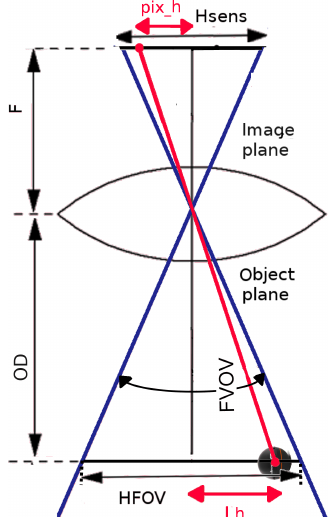
Figure 4. Relationship between FOV (field of view in degrees), HFOV (height of the field of view, in metric unit), OD (object dis- tance), F (focal length), pix h (distance in pixels between center of the image and the object in the image, along the vertical axis of the image captured by the camera), Hsens (sensor height), and Lh (distance in metric units between the object and center of the sen- sor along the vertical axis of the image). The drawing is valid under the assumption that the image distance (distance from the rear nodal point of the lens to the image plane) corresponds to the focal